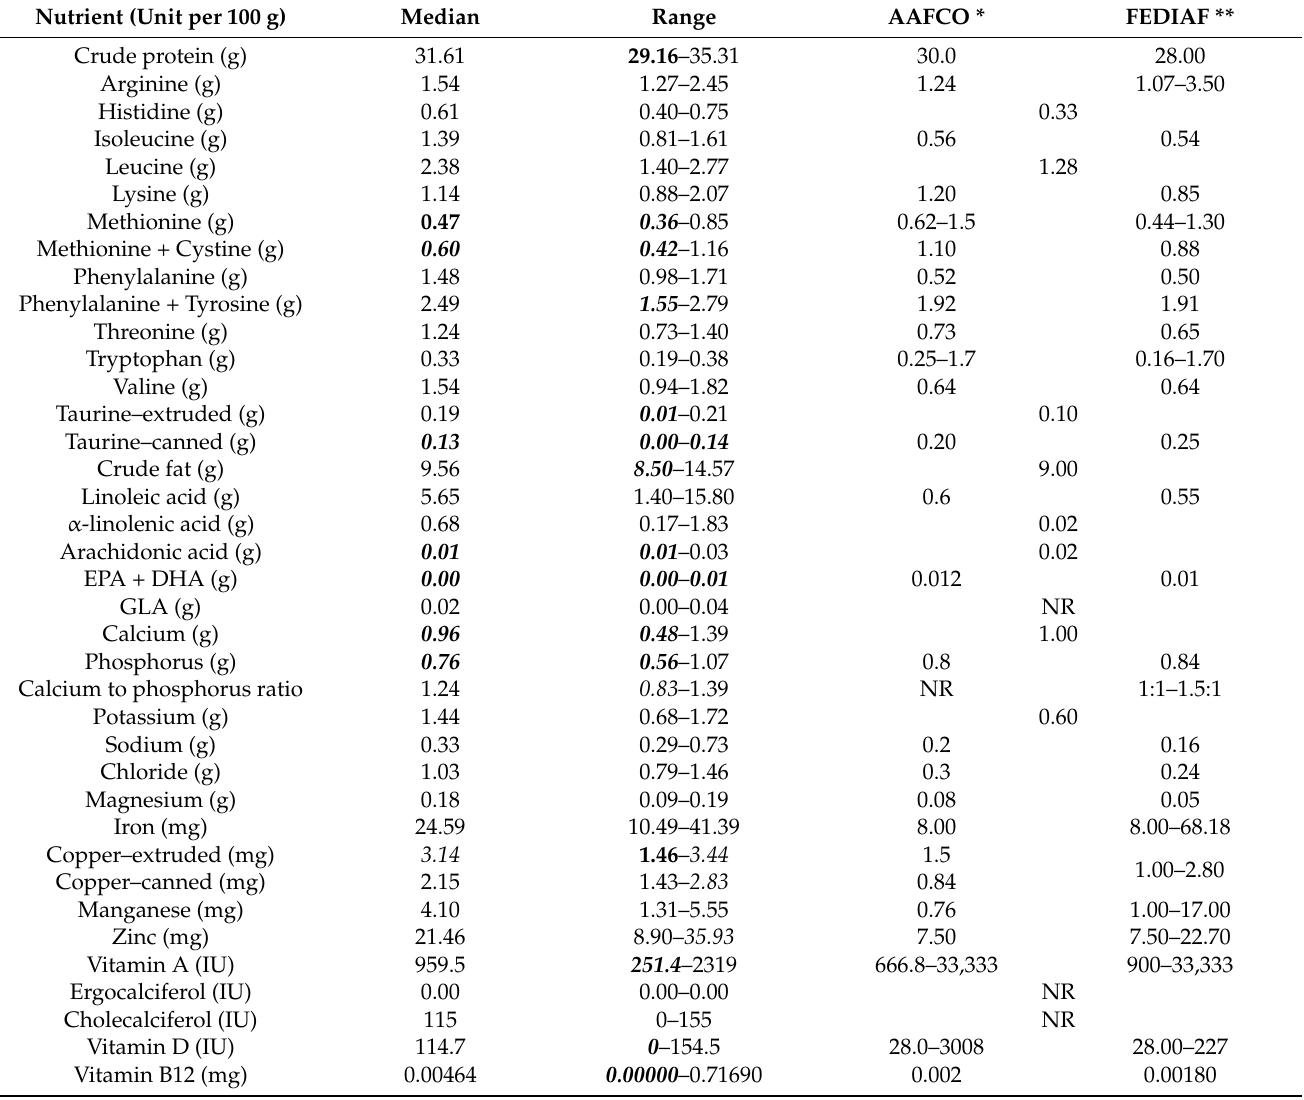
Table 4. Measured nutrient content in five plant-based feline foods commercially available in Canada and labeled for growth or all life stages compared to the AAFCO and FEDIAF recommended essential nutrient concentrations for feline growth on a dry matter basis (unit per 100 g dry